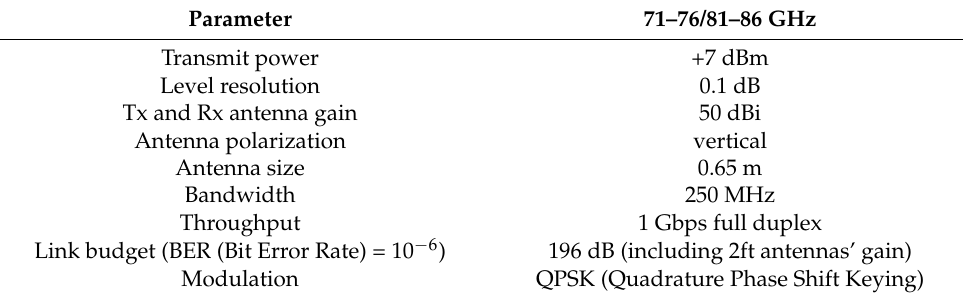
Figure 1. ( a ) E-band radio transceiver; ( b ) the CLIMA laser precipitation monitor. Table 1. System parameters of the E-band link